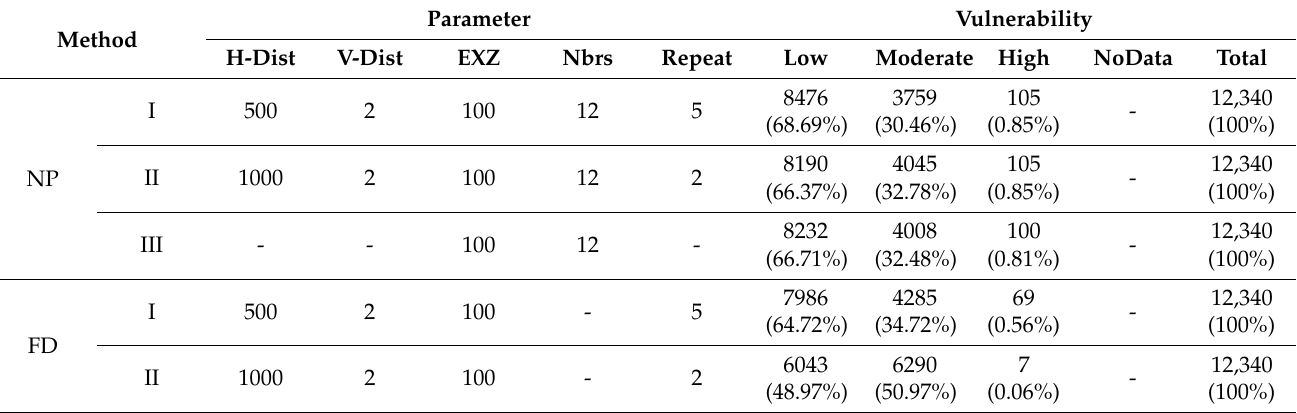
Table 2. Summary of final interpolation